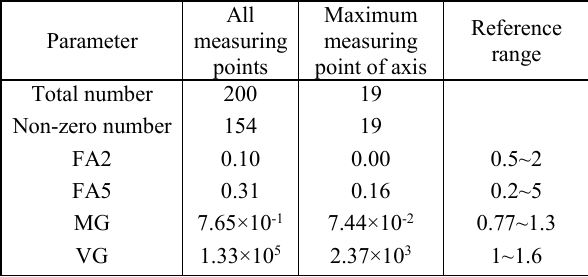
Table 4. Statistical result